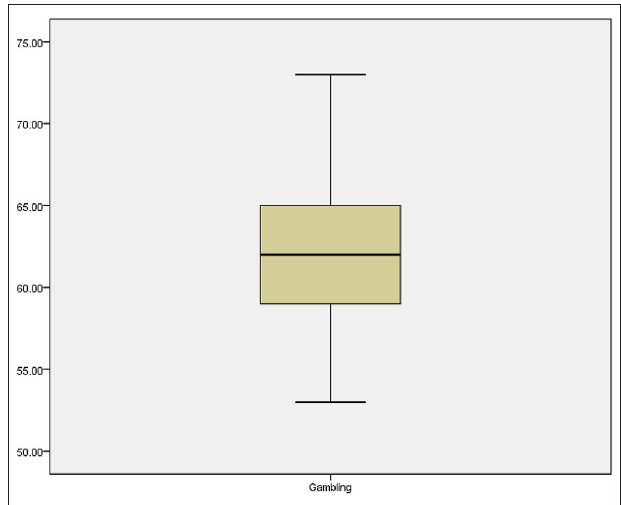
FIGURE 2 | The box